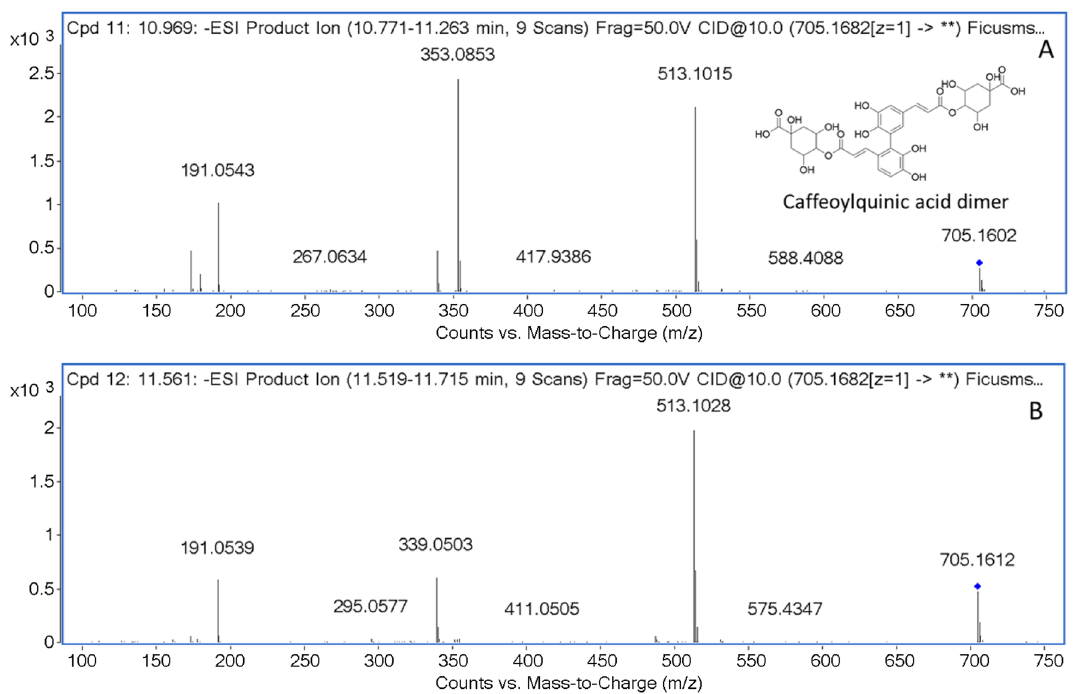
Figure 3. MS/MS data and proposed structure of caffeoylquinic acid dimer and compounds 9 ( A ) and 11 ( B ).